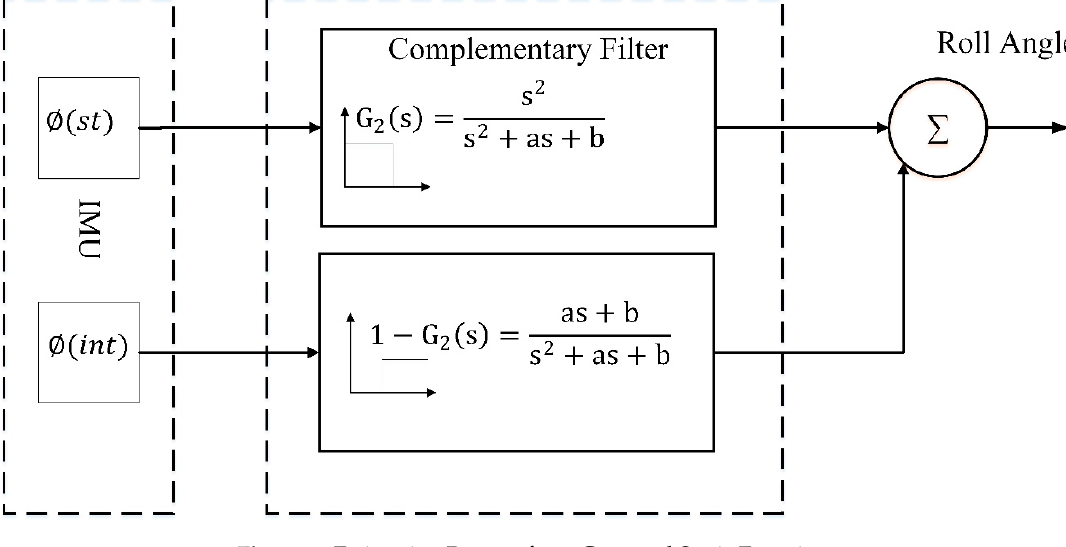
Figure 7. Estimation Process from Gyro and Static Equation .